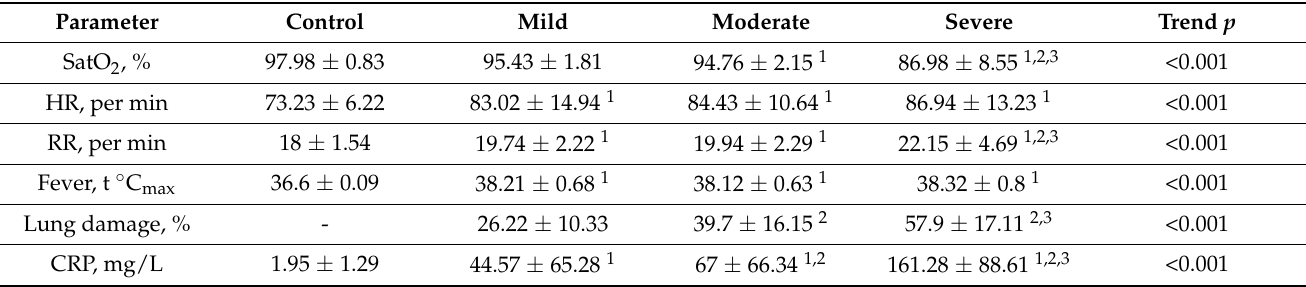
Table 1. Characteristics of the disease severity in COVID-19 patients.